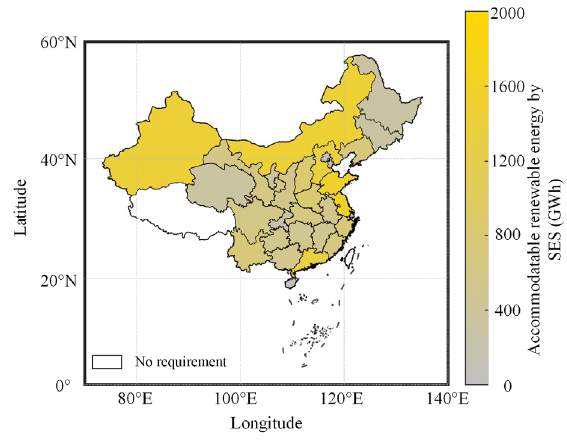
Figure 9. Renewable energy accommodated by SES of China in 2030.